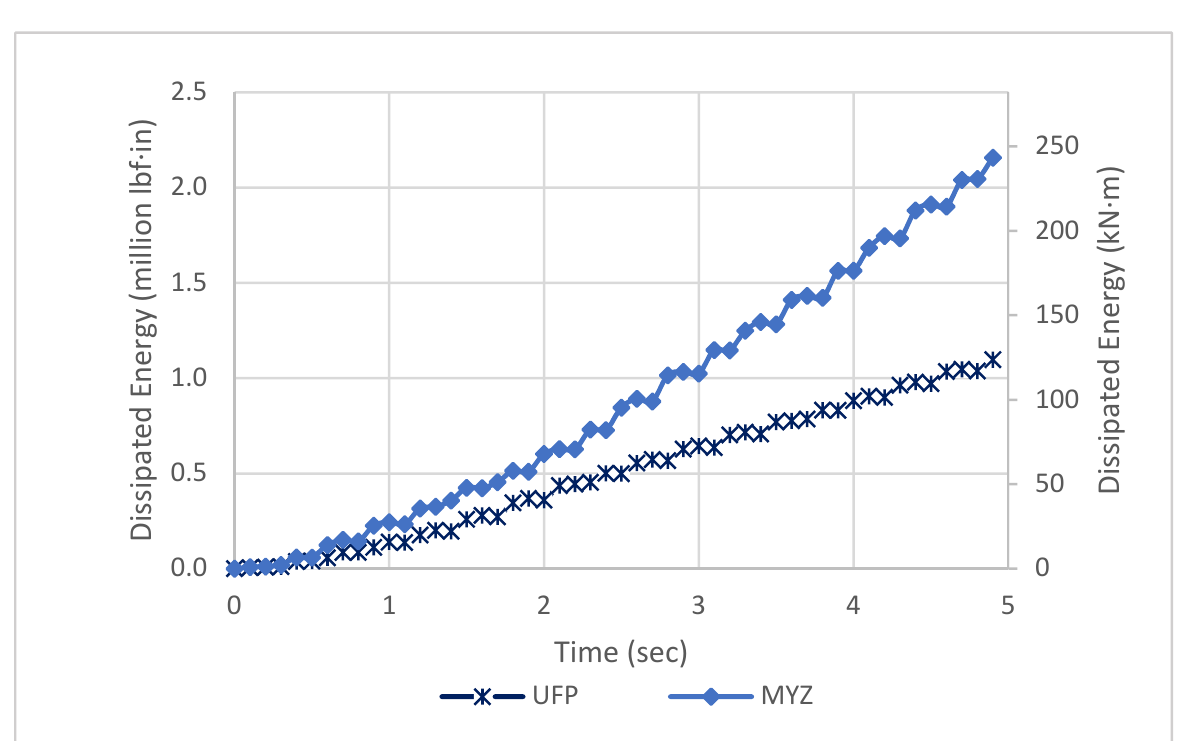
Figure 21. Base shear for UFP and MYZ.